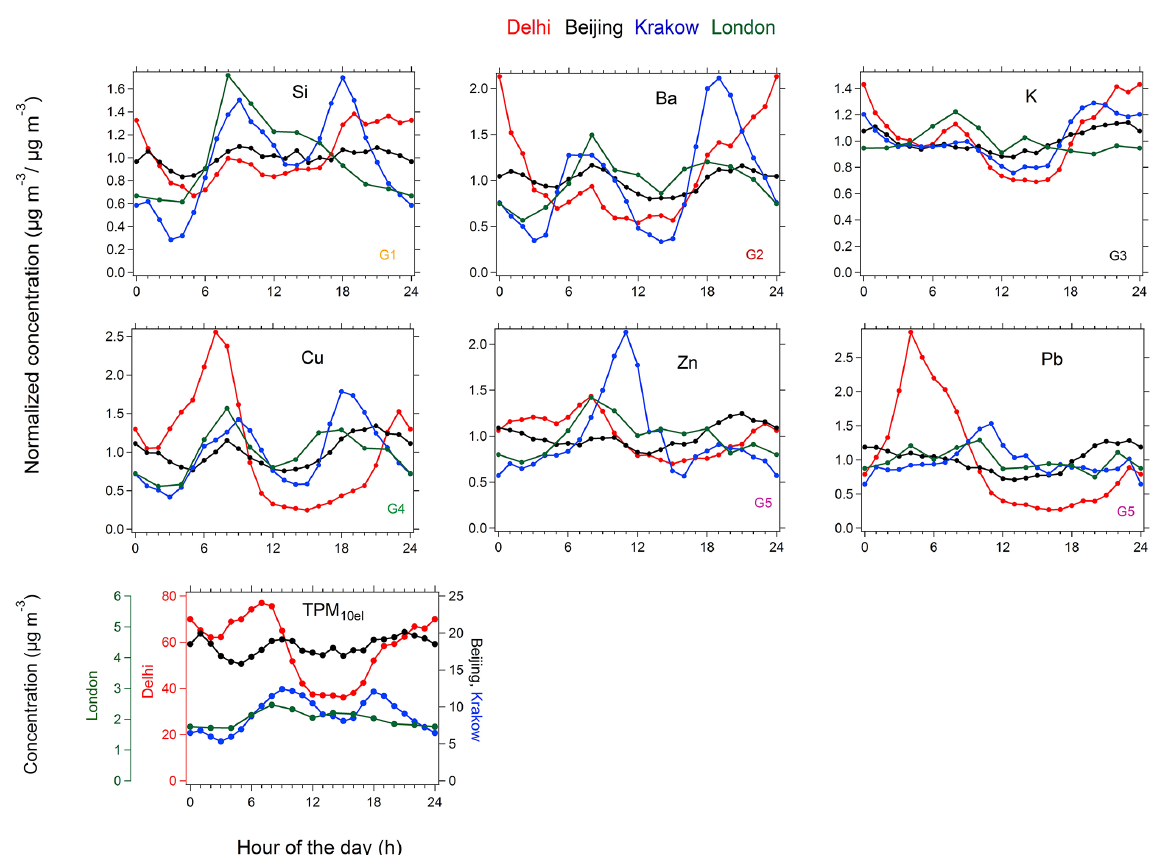
Figure 4. Diurnal patterns (means) of selected elements representative of each group (G1: Group 1, G2: Group 2, G3: Group 3, G4: Group 4, G5: Group 5) in PM 10 normalized by the mean values of the elements in PM 10 and the total elemental PM 10 (in µgm − 3 , bottom) at all sites. Note that due to the time resolution of the original data, the London data are 2h averages, while the other data are 1h